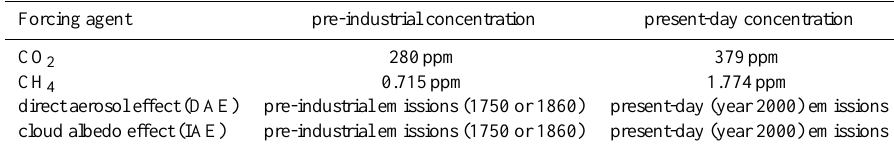
Table 1. Experimental